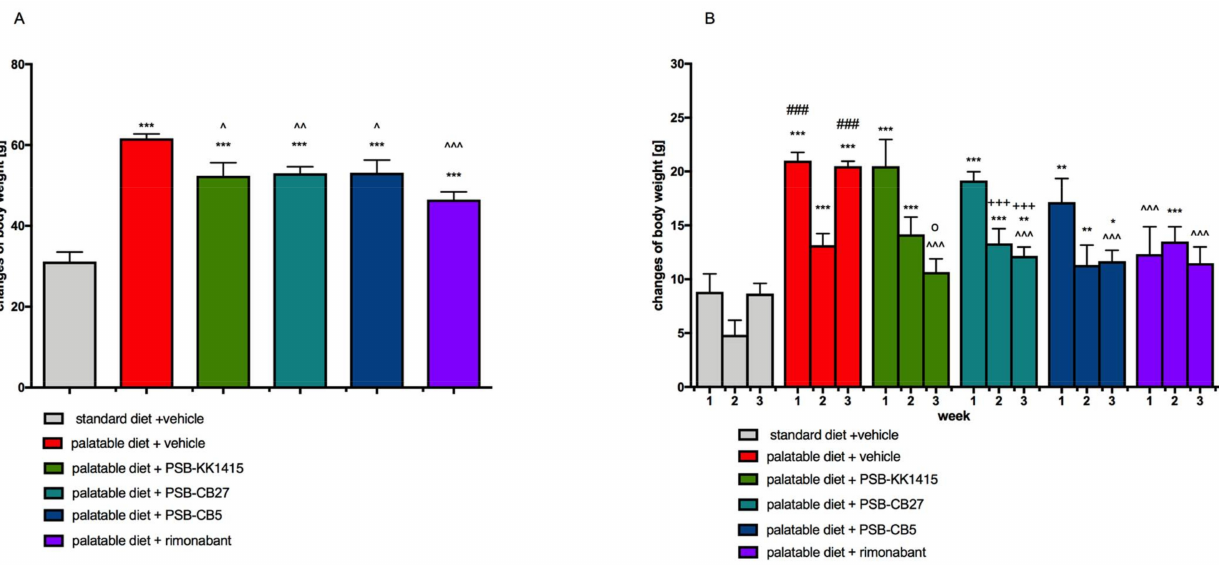
Figure 1. Effect of diet or long-term administration of the GPR18 ligands or rimonabant, on body weight of female Wistar rats in the model of excessive eating. ( A ) Sum of body weight changes. ( B ) Changes of body weight in individual weeks. Result are means ± SEM, n = 6. Multiple comparison against the vehicle-treated control group (*) or against the vehicle-treated obese control group (ˆ) or against the vehicle-treated obese control group in second week (#) or against the PSB-KK1415-treated group in first week (o) or against the PSB-CB27-treated group in first week (+) were performed by one-way ANOVA Tukey post hoc. Significant differences are denoted by *,ˆ,o p < 0.05; **,ˆˆ p < 0.01; ***,ˆˆˆ,###,+++ p <